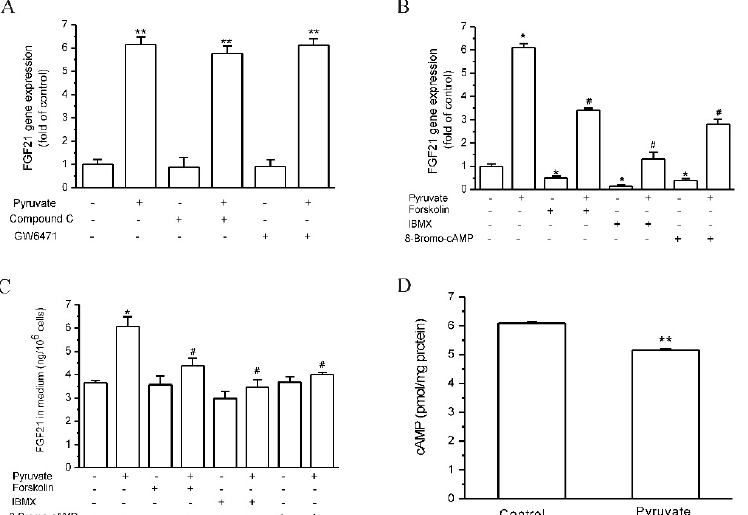
Figure 2. cAMP reduction caused pyruvate-stimulated FGF21 expression in HepG2 cells. ( A ): The activation of PPAR- α and AMPK was not involved in pyruvate-stimulated FGF21 expression (** p < 0.01 vs. control, n = 3). ( B ): AC activator forskolin, PDE inhibitor IBMX and 8-Bromo-cAMP administration significantly inhibited FGF21 expression and suppressed pyruvate-stimulated FGF21 expression (* p < 0.05 vs. control, # p < 0.05 vs. pyruvate group, n = 3). ( C ): Forskolin, IBMX and 8-Bromo-cAMP inhibited pyruvate-stimulated increase in FGF21 protein levels in cell medium (* p < 0.05 vs. control, # p < 0.05 vs. pyruvate group, n = 10). ( D ): Pyruvate decreased intracellular cAMP levels in HepG2 cells (** p < 0.01 vs. control, n = 12). The intracellular cAMP level is determined by the balance between AC-catalyzed cAMP production and PDE-catalyzed cAMP hydrolysis. The activities of AC and PDE in HepG2 cells were then measured, and it showed that pyruvate significantly increased PDE activities in HepG2 cells ( p < 0.05; n = 5; Figure 3A). In contrast, AC activities were not influenced by pyruvate in HepG2 cells (Figure 3B).